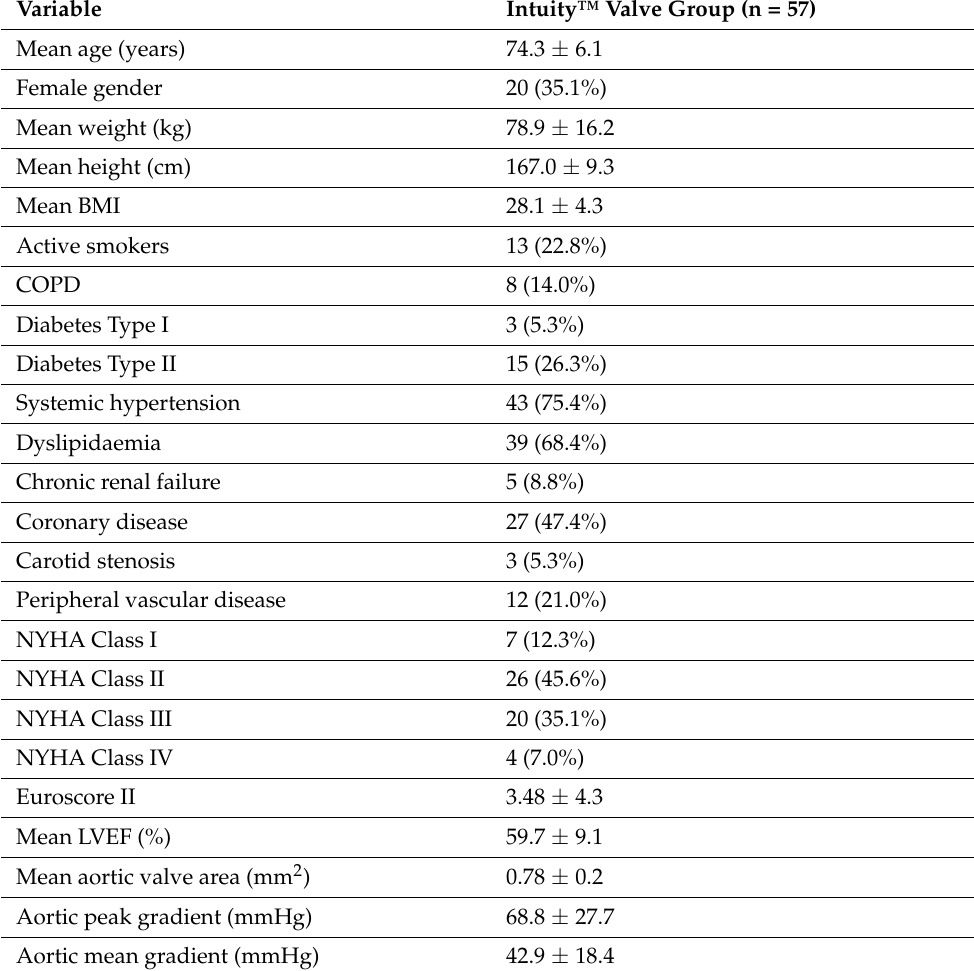
Table 1. Patients’ characteristics.